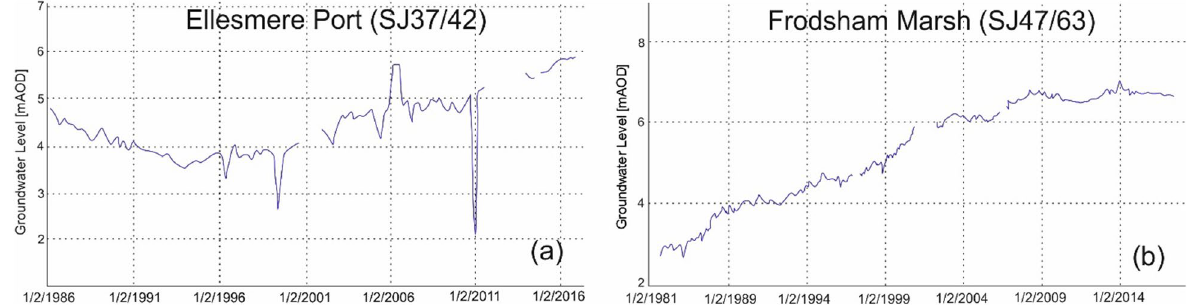
Figure 7. Groundwater levels in the Cheshire Observatory area. Groundwater level for ( a ) Ellesmere Port and ( b ) Frodsham Marsh. For their location see Fig. 1. Contains Environment Agency